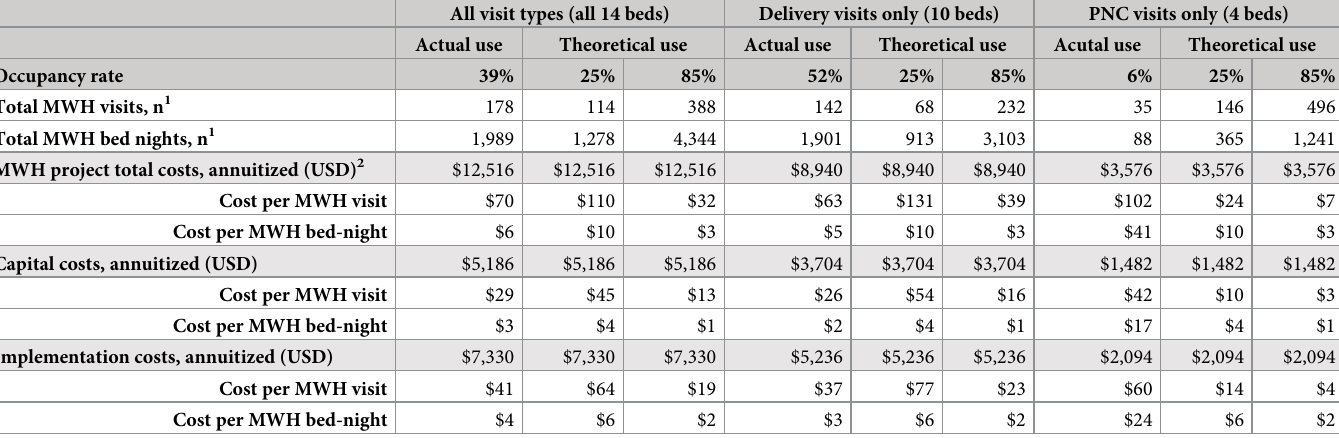
Table 3. Annuitized cost per maternity waiting home stay over a 12-month period, by bed space allocation, occupancy rates (actual vs. theoretical low and high sce- narios), and type of costs (total, capital, and installation). All visit types (all 14